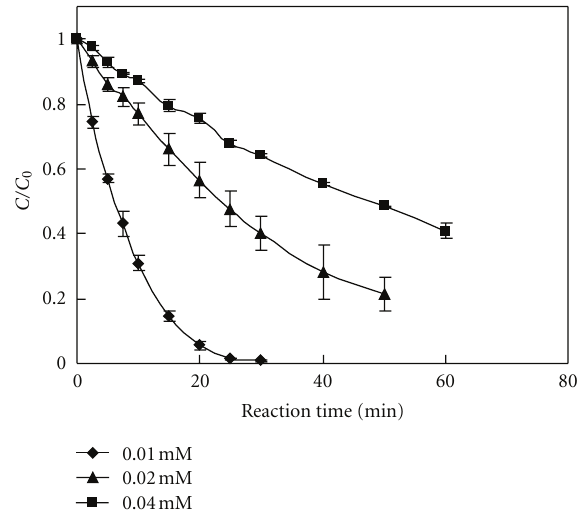
Figure 4: RhB degradation rate during the UV/K 2 S 2 O 8 treat- ment system at di ff erent dye initial concentration. Conditions: [K 2 S 2 O 8 ] = 0 . 4mM, no pH adjustment.